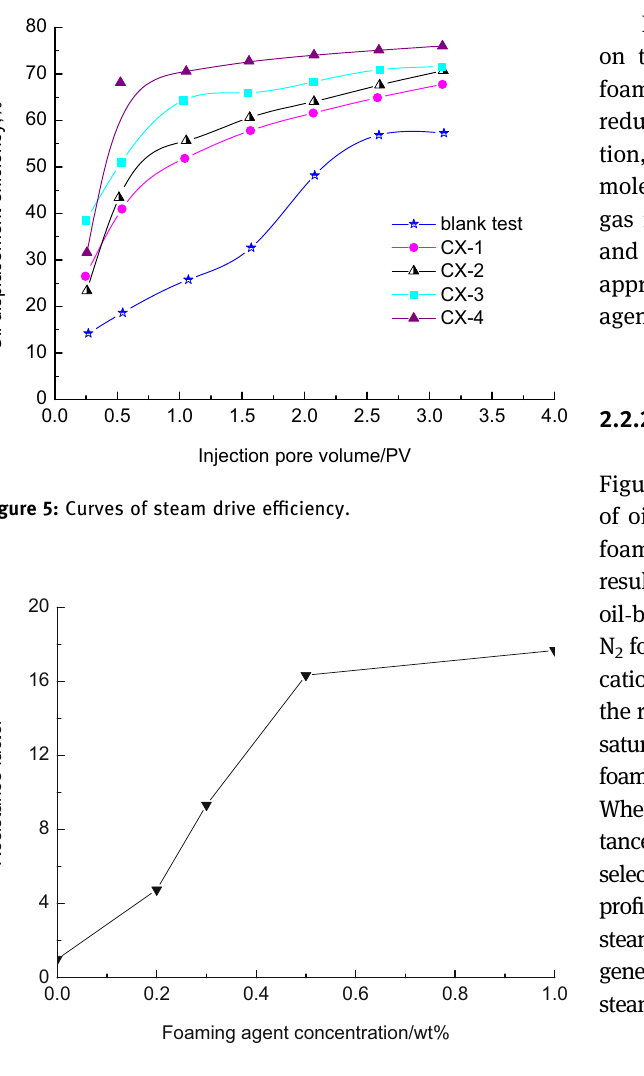
Figure 6: In fl uence of foaming agent concentration on the resistance